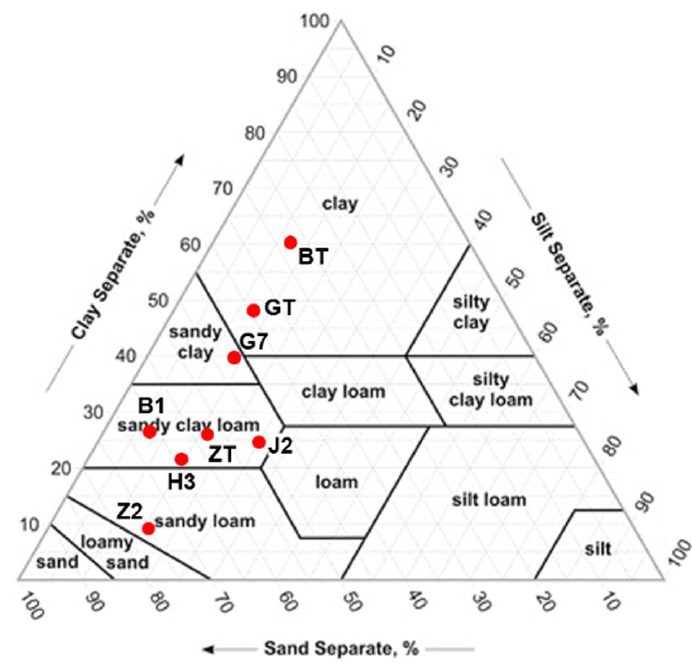
Figure 2. Triangular diagram of soil